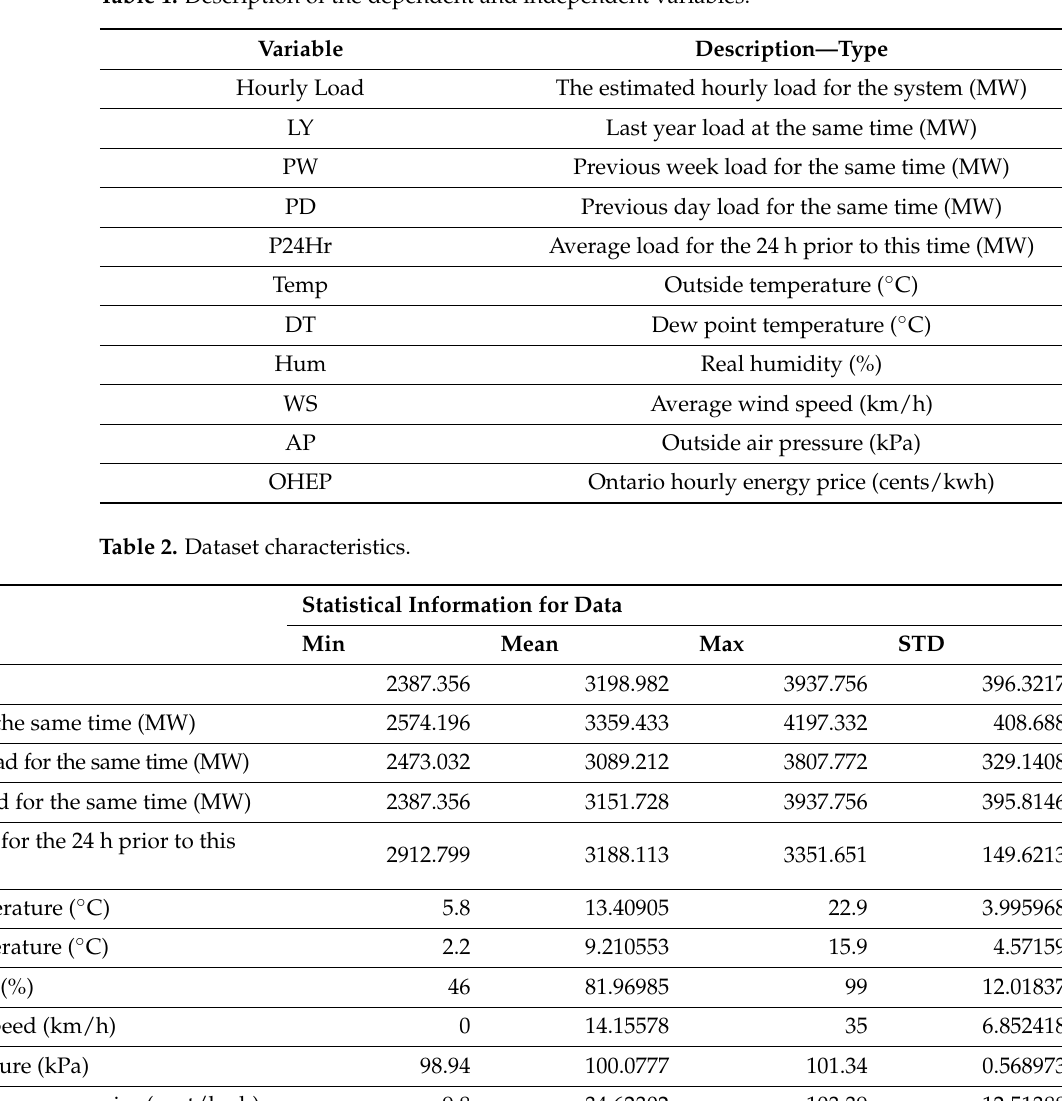
Table 1. Description of the dependent and independent variables.